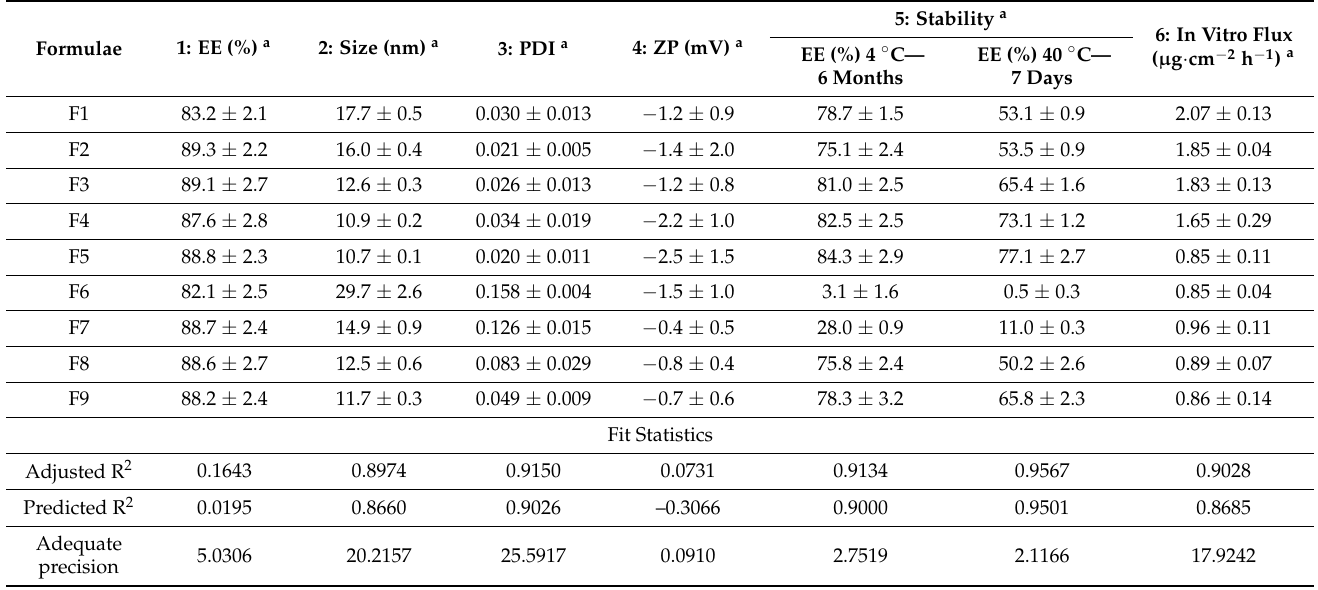
Table 2. Studied parameter responses and modeling data based on a quadratic